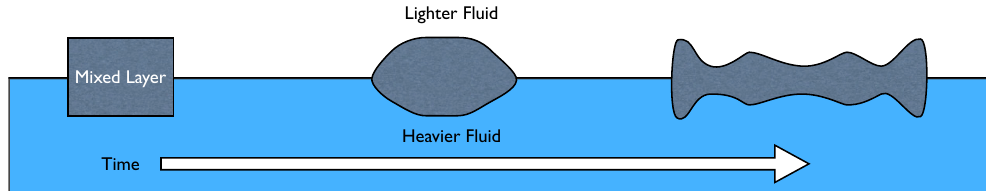
Fig. 1. Diagram of the basic experimental setup for numerical